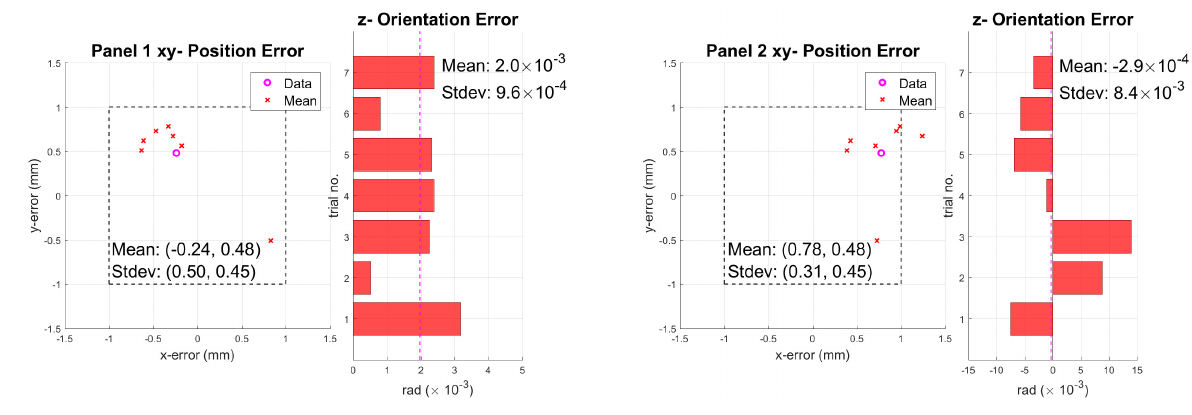
Figure 11. Panel placement errors over 7 trials indicates alignment error within 1 mm for the x - y position and 0.1 degree for